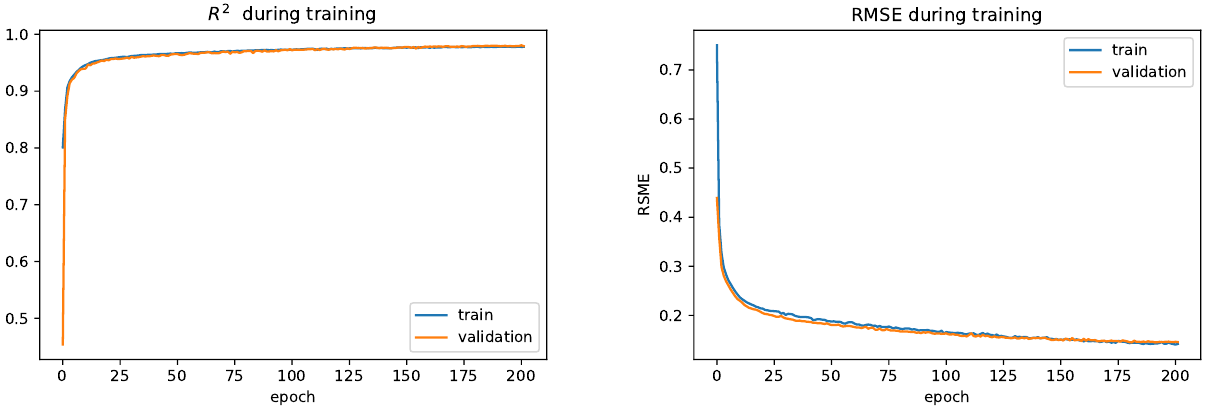
Figure 8. R 2 and RMSE during training. The left side shows the R 2 -score and the right side shows the RMSE.